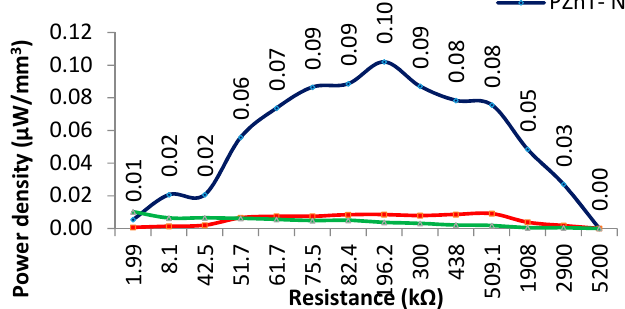
Figure 13. Power density of piezoelectric devices versus the resistance.